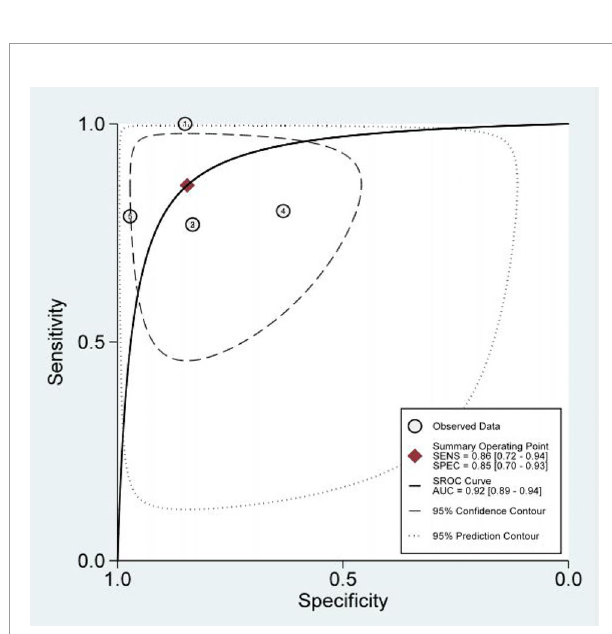
FIGURE 7 | The SROC curve of serum HE4 after third